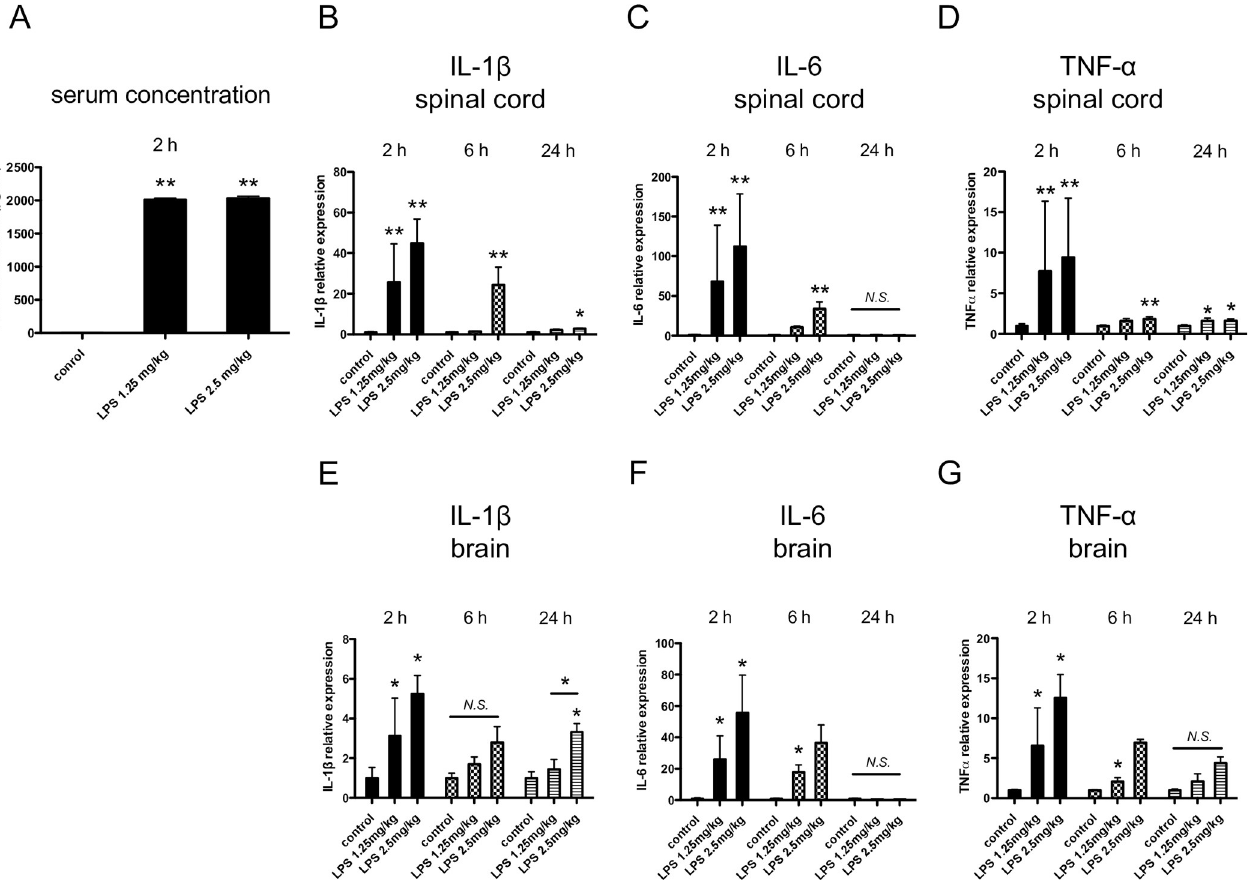
Fig 1. Effect of intraperitoneal lipopolysaccharide (LPS) administration on pro-inflammatory cytokine expression in mouse spinal cords. LPS 1.25 or 2.5 mg/kg, or the same amount of normal saline, was intraperitoneally administrated to 10-week-old BALB/c male mice. (A) Two-hour after the LPS administration, serum IL-6 concentration was determined with enzyme-linked immunosorbent assays (ELISA) (n = 4–5). mRNA expression levels of pro- inflammatory cytokines were determined in their spinal cords (B–D) and brains (E–G). 2, 6, and 24 h after LPS administration. Interleukin (IL)-1 β (B and E), IL-6 (C and F), and tumor necrosis factor alpha (TNF α ) (D and G) mRNA were assayed using real-time quantitative polymerase chain reactions (qRT-PCR; n = 4–7), and the expression levels were normalized to those of 18S rRNA and expressed relative to the mean in control mice. Data are presented as means ± standard deviations (S.D.); � P < 0.05 versus control; �� P < 0.01 versus control; N.S., not